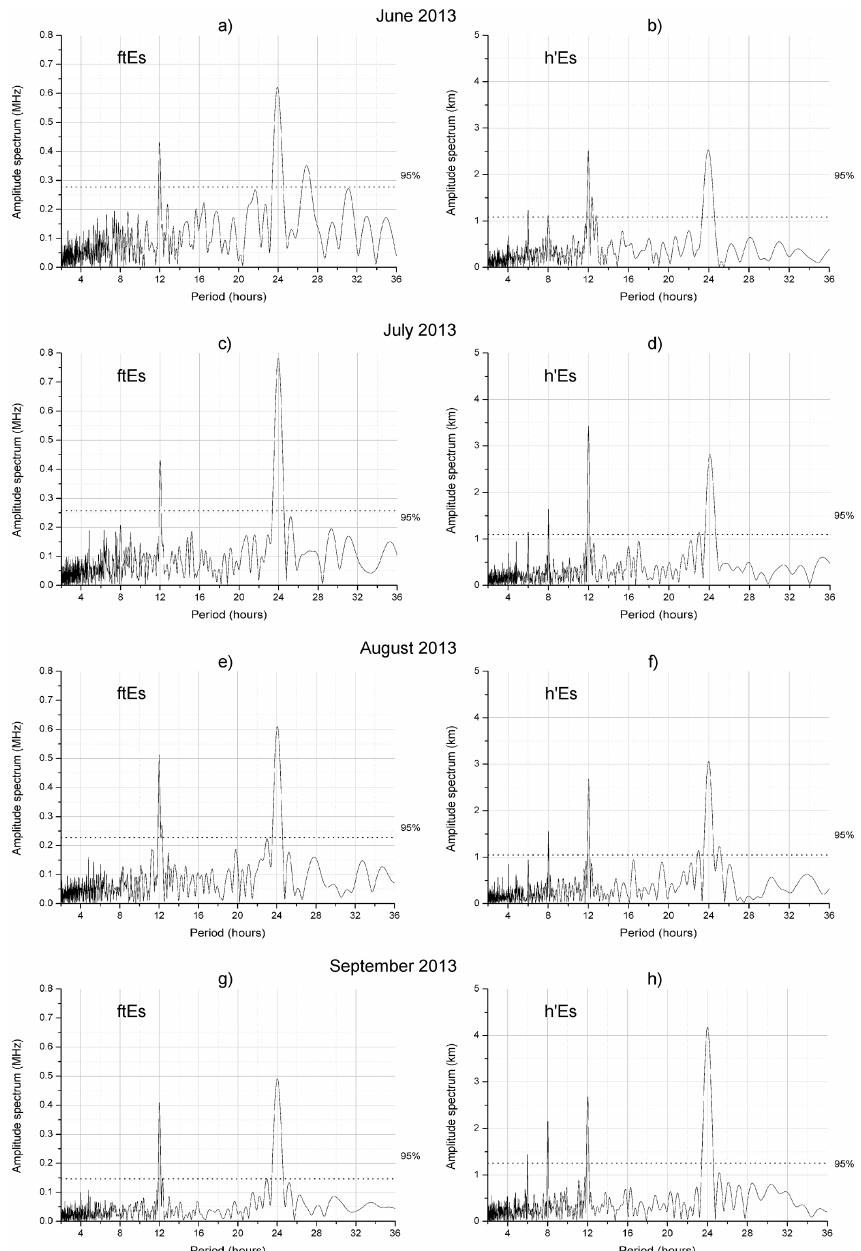
Figure 10. FFTs of the ftEs and h’Es hourly mean values recorded at Rome in (a – b) June, (c – d) July, (e – f) August, and (g – h) September